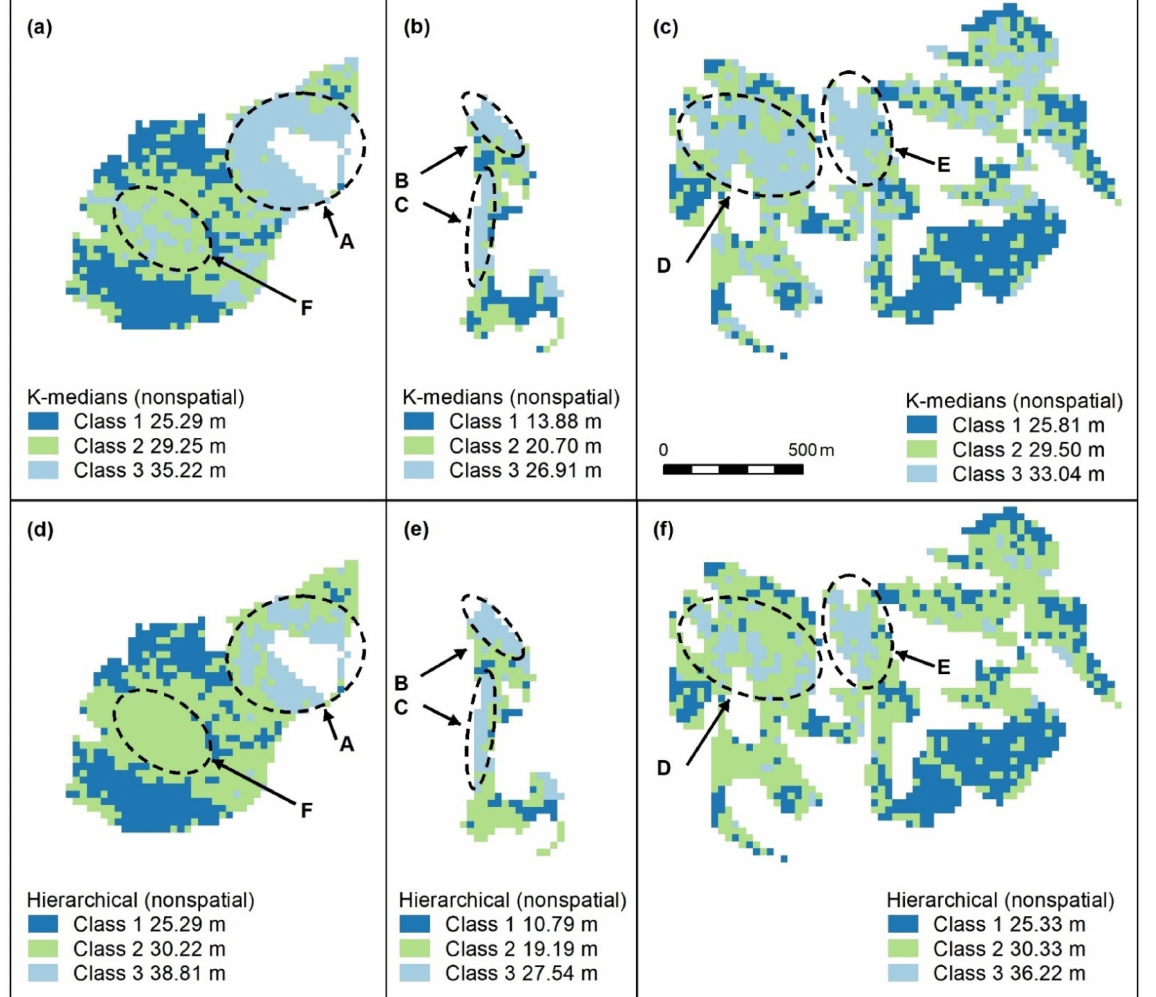
Figure 10. Nonspatial K-medians ( a – c ) and nonspatial hierarchical cluster maps ( d – f ) for individual polygons with 3 height classes. Letters A–F indicate areas of higher canopy as shown in Figure 9. Five of six features were identified, and cluster areas are similar except for feature D ( c , f ). Feature F was partially captured by K-medians ( d